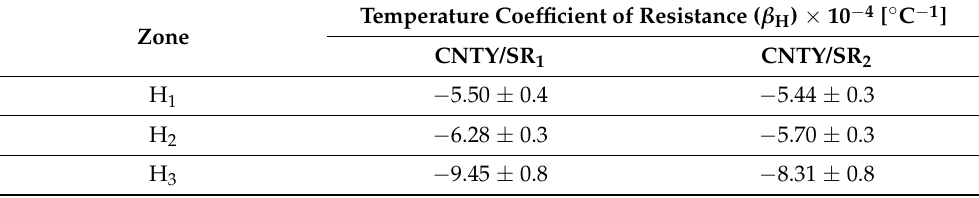
Table 2. Temperature coefficients of resistance extracted during heating-dwell temperature program.